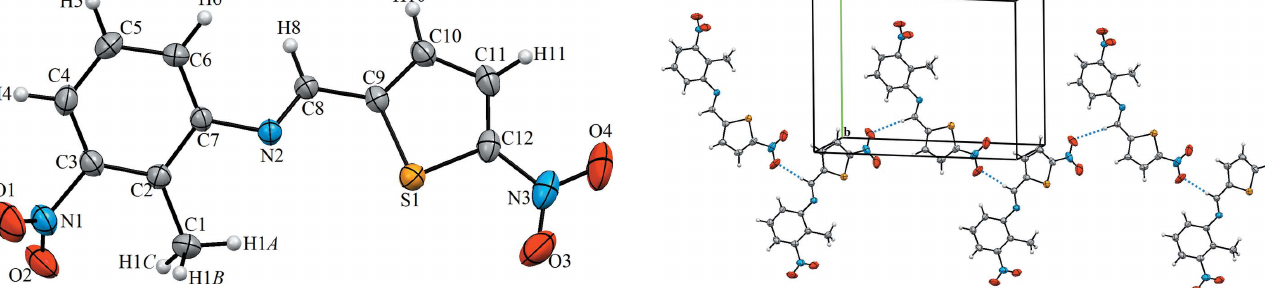
Figure 1 The molecular structure of the title compound with the atom-labelling scheme. Displacement ellipsoids are drawn at the 30% probability